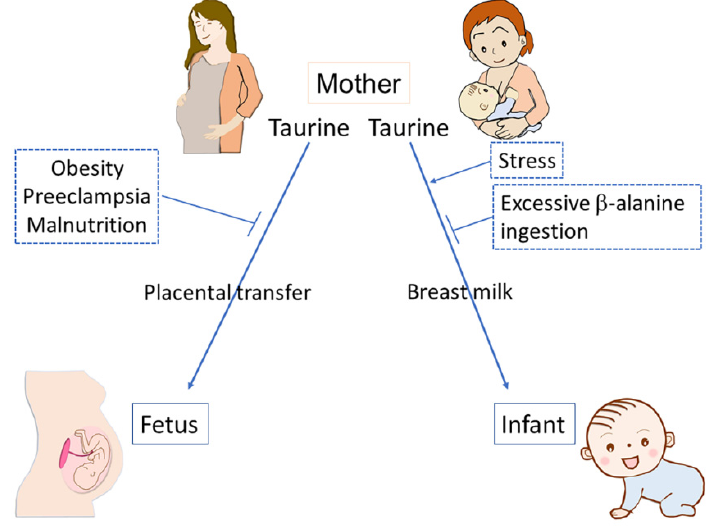
Figure 3. Taurine transfers from mother to offspring via either the placenta or breast milk and several environmental factors affect the transfer of taurine. Maternal obesity, preeclampsia, and malnutrition can inhibit the placental transfer of taurine. Excessive β -alanine ingestion can inhibit taurine transfer via breast milk, while maternal stress can enhance